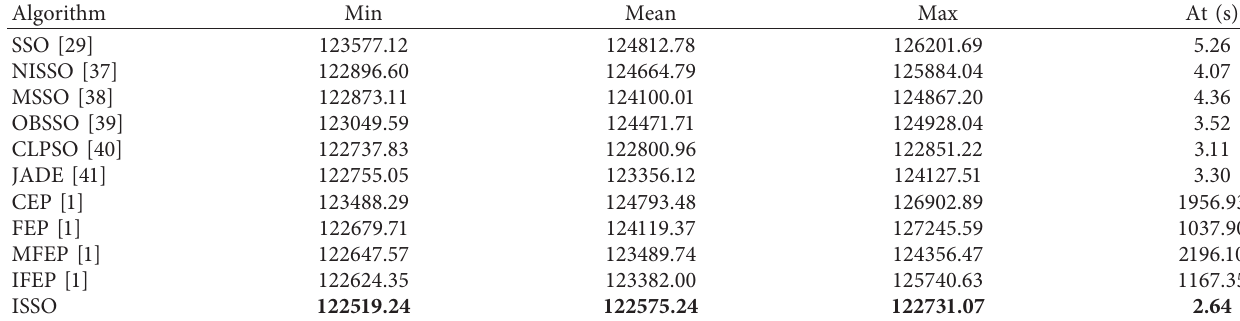
Table 6: Comparisons of the results of 40-unit system with P